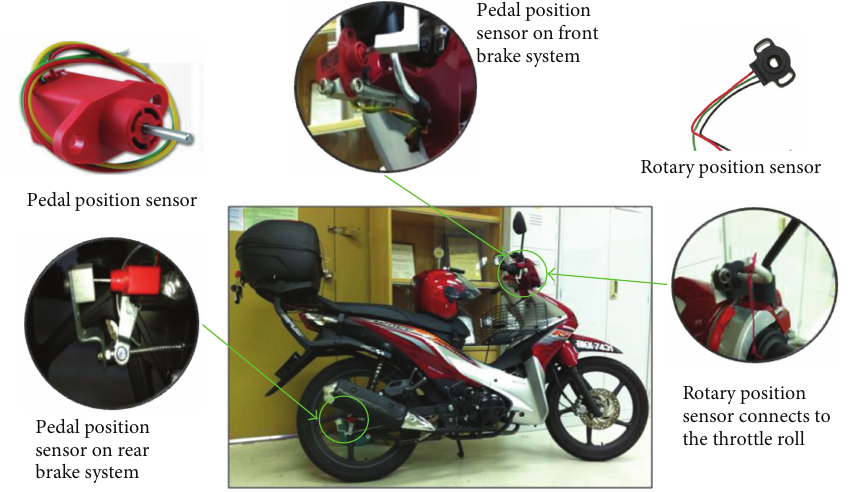
Figure 1: Snapshot of the instrumented motorcycle.